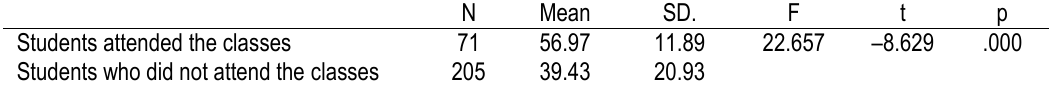
Table 7. Comparison of the Mean Scores of Final Results of the Two Groups N Mean